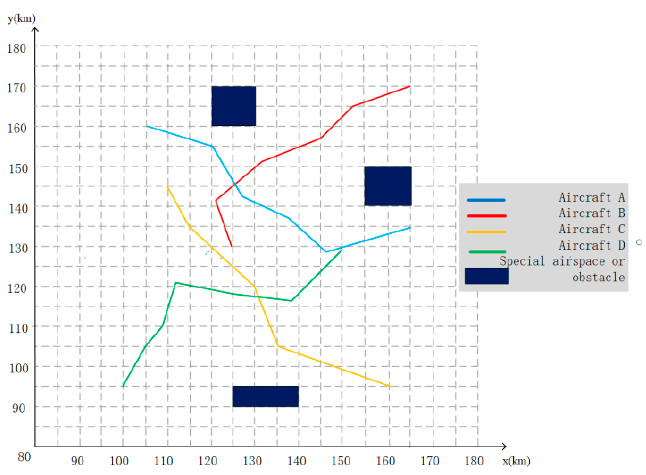
Figure 11. Schematic of the potential motion space of the four aircrafts. The track planning results after the second layer of the D* algorithm is used are shown